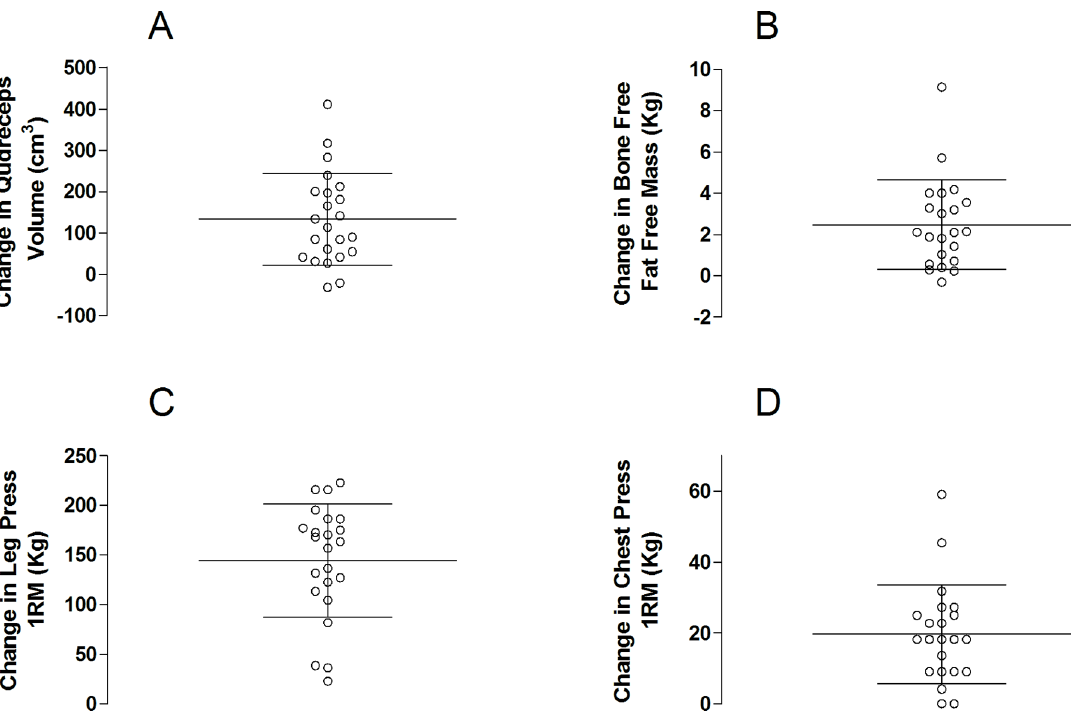
Figure 1. Muscle volume, muscle mass, and strength changes following resistance training. The absolute increase in A) Quadriceps muscle volume determined by MRI, B) Fat free bone free mass determined by DXA, C) Leg press 1RM and D) Chest press 1RM. Each dot represents a single subject, the lines show the group mean change and the standard deviation of the mean. All increases were significantly different from zero (i.e., an increase from pre training P , 0.05).